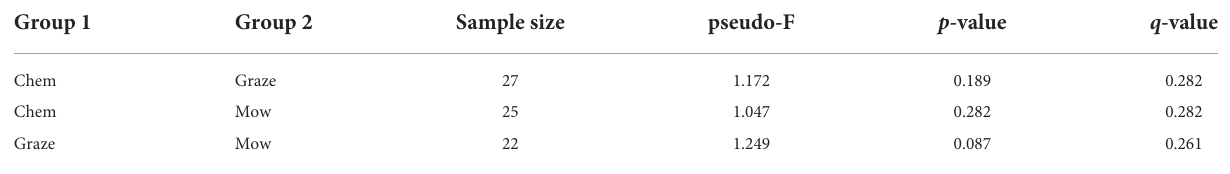
TABLE 2 Pair-wise permutational analysis of variance (PERMANOVA) for multivariate ( β -diversity) group significance for each cover crop termination method. Group 1 Group 2 Sample size pseudo-F p -value q -value